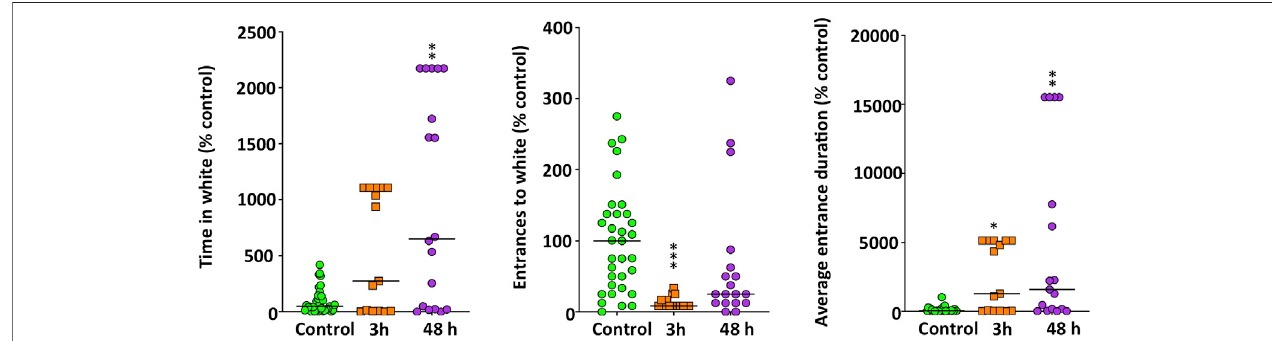
FIGURE 3 | Anxiety-like behavior, assessed in standard 6-min dark-light test (DLT), in adult zebra fi sh waterborne exposed to 40 mg/L methamphetamine (METH) for 3 and 48 h. Data from each experiment were normalized to the corresponding control values. The combined data is reported as scatter plot with the median ( n (cid:2) 15 – 18), * p < 0.05, ** p < 0.01, *** p < 0.001; Kruskal Wallis test with Bonferroni correction. Data from two independent